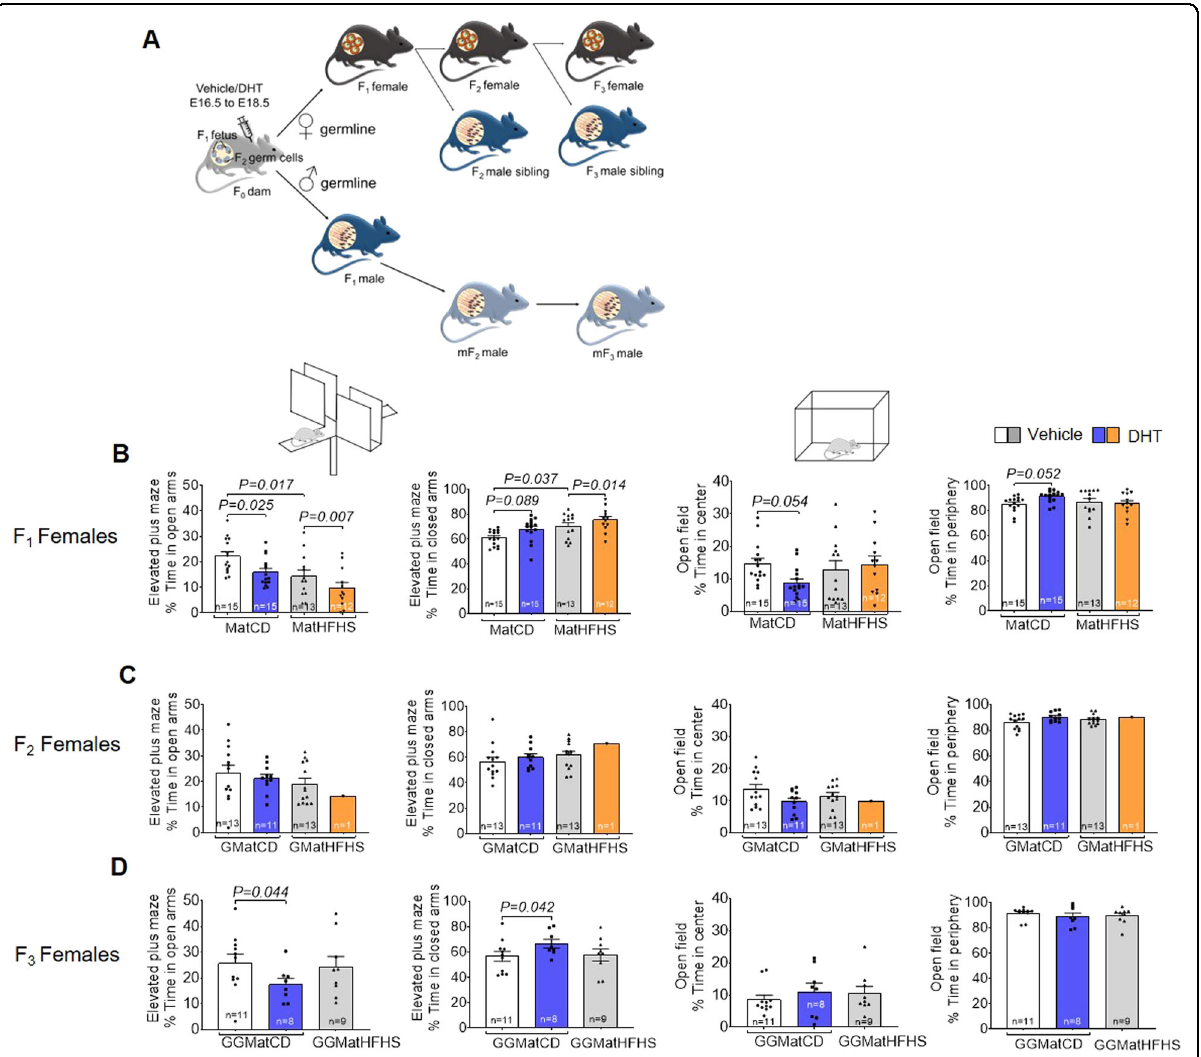
Fig. 2 Prenatal androgen exposure causes transgenerational anxiety-like behavior in female offspring. A Schematic illustration of experimental design. Prior to mating with male mice fed control diet, F 0 mothers were fed control diet or high fat-high sucrose (HFHS) diet for 6 weeks. During embryonic day (E) 16.5 − E18.5 pregnant mice were injected subcutaneously with 250 µg of dihydrotestosterone (DHT), a non- aromatizable androgen, dissolved in 50 µL of sesame oil or 50 µL of sesame oil alone (vehicle) resulting in four lineages; CD + Vehicle (control); CD + DHT (androgenized); HFHS + Vehicle (obese); and HFHS + DHT (obese- androgenized). F 1 female and male offspring were mated with unrelated males and females fed CD, respectively, to generate F 2 and thereafter to generate F 3 offspring. Anxiety-like behavior was tested in female and male offspring according to the graph. Male germline refers to F 2 and F 3 male offspring from F 1 males. F 2 and F 3 male siblings are brothers to F 2 and F 3 female offspring. B – D Time spent in the open arms in the elevated plus maze (EPM); time spent in the closed arm of the EPM; time spent in the center of the open fi led (OF); time spent in the periphery of the OF. F1: two-way ANOVA, Tukey ’ s post hoc analysis; F 2 and F 3 : one-way ANOVA, Dunnett ’ s post hoc analysis. All data are presented as mean ± s.e.m. DHT dihydrotestosterone, CD control diet, HFHS high-fat high-sugar, Mat maternal, GMat grand-maternal, GGMat great-grand maternal. Numbers of mice are stated in the bars of each